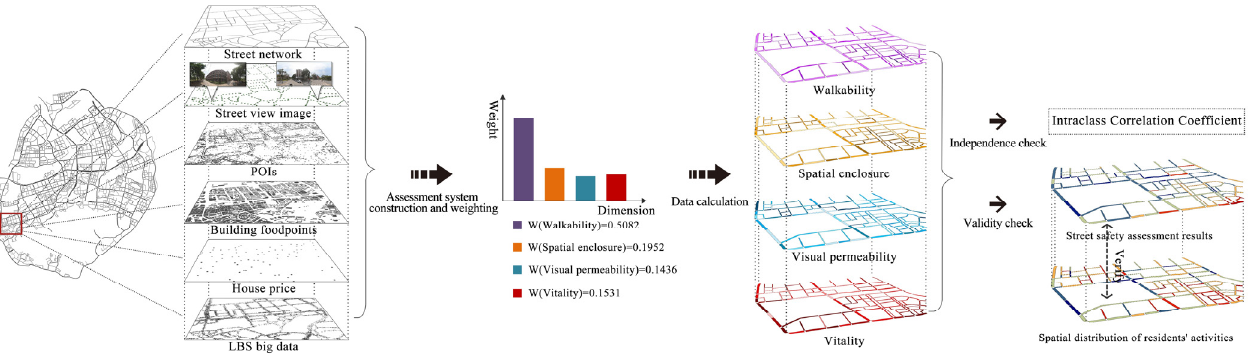
Figure 4. Workflow of assessing street safety using multisource data.